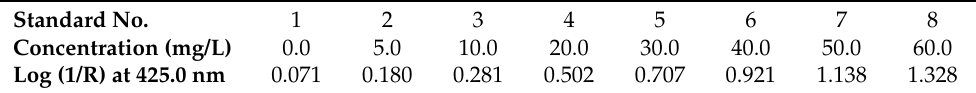
Table 2. Absorbance of quercetin-3-glucoside at different concentrations. Standard